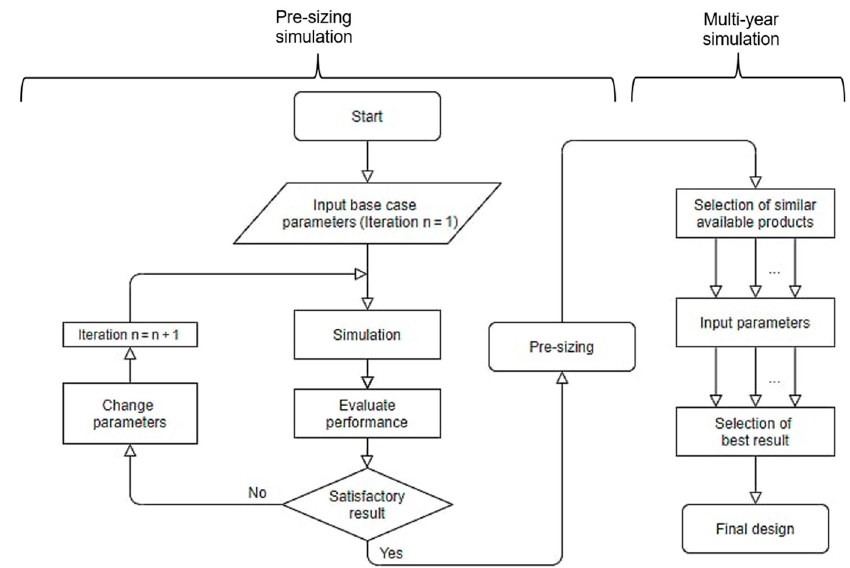
Figure 2. Sizing and optimization procedure. Table 3. Results of pre-sizing grid-connected PV systems without batteries (GRID-PV-ONLY).